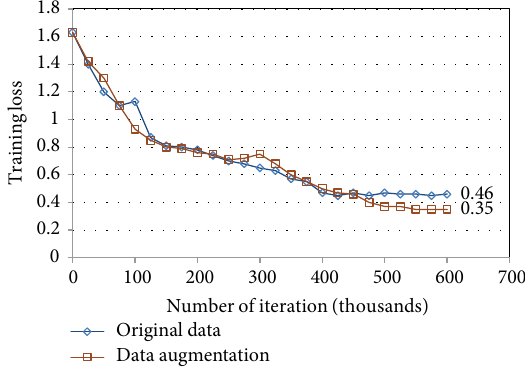
Figure 16: Effect of data augmentation on